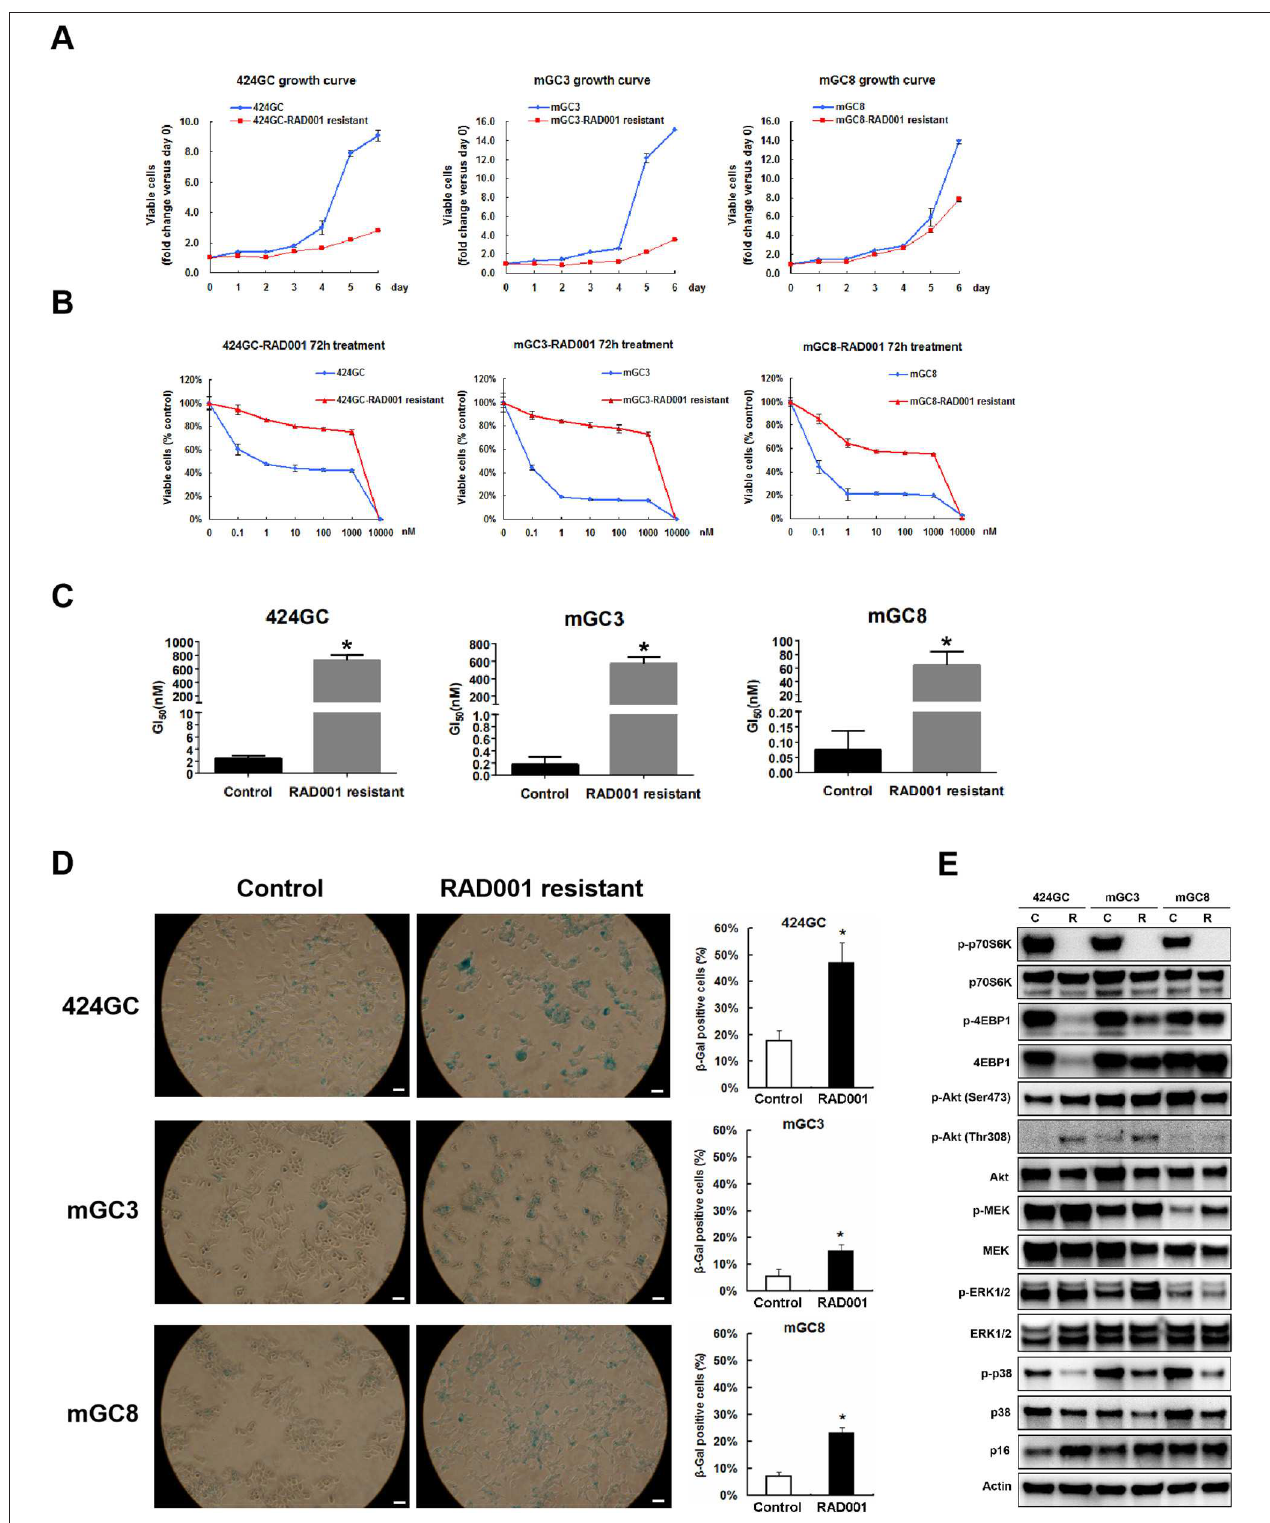
FIGURE 5 | Study on the RAD001 resistant cell lines. (A) Growth curves of RAD001 resistant cell lines and the parental untreated cell lines. A slowed down proliferation was observed in the resistant cell lines comparing to the parental untreated cell lines even being cultured in RAD001 free medium. (B) Cell viability assay